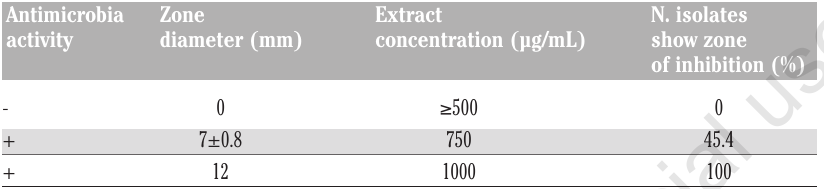
Table 1. Antimicrobial activity of methanolic extract of S. persica against H. pylori iso- lates by agar ditch method. Antimicrobia